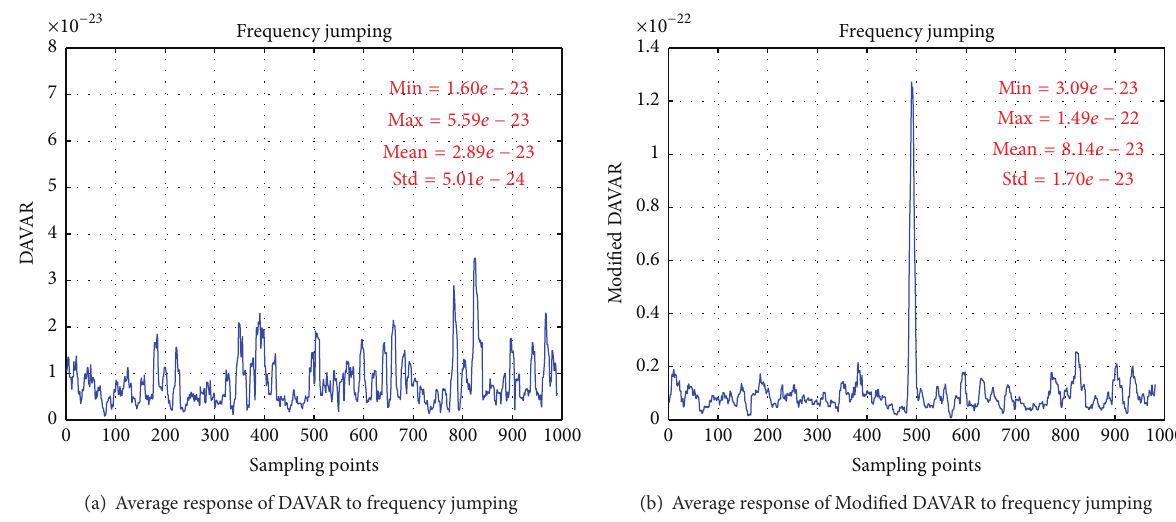
(b) Average response of Modified DAVAR to frequency jumping Figure 9: Comparison of two variances for frequency jumping.